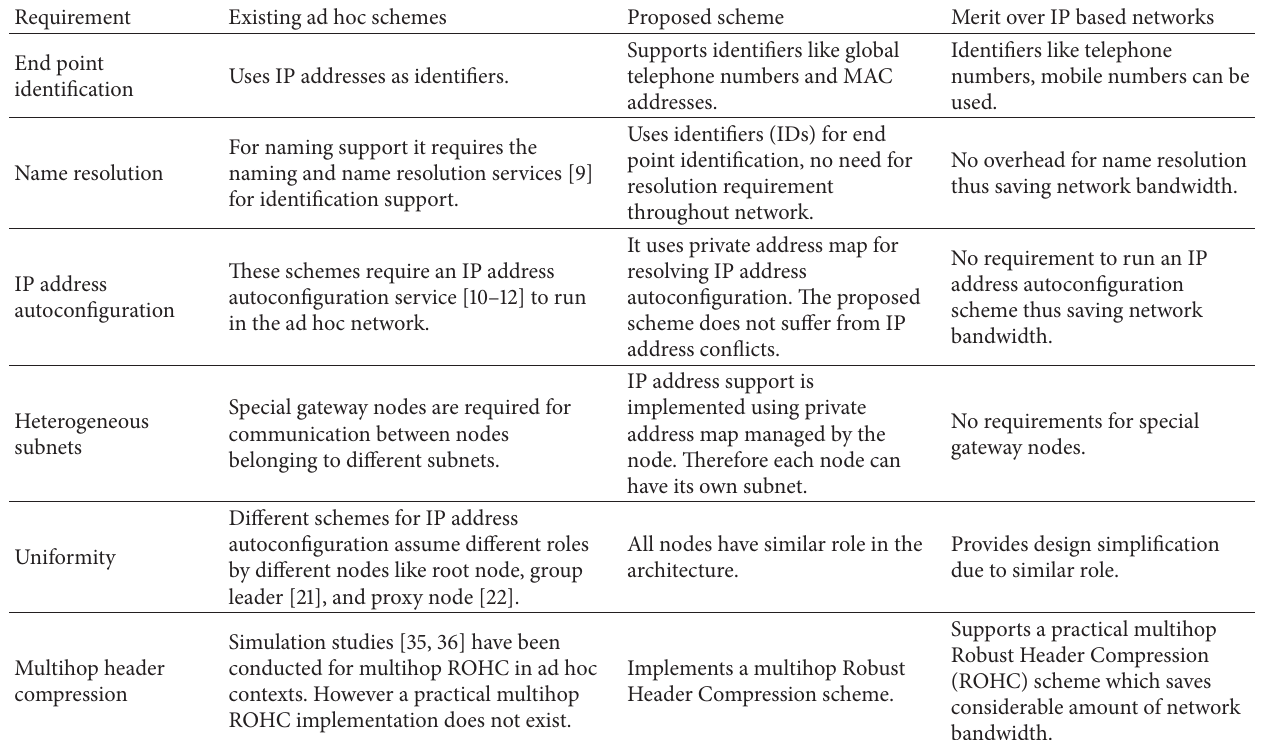
Table 5: Comparison between IDHOCNET and IP based ad hoc